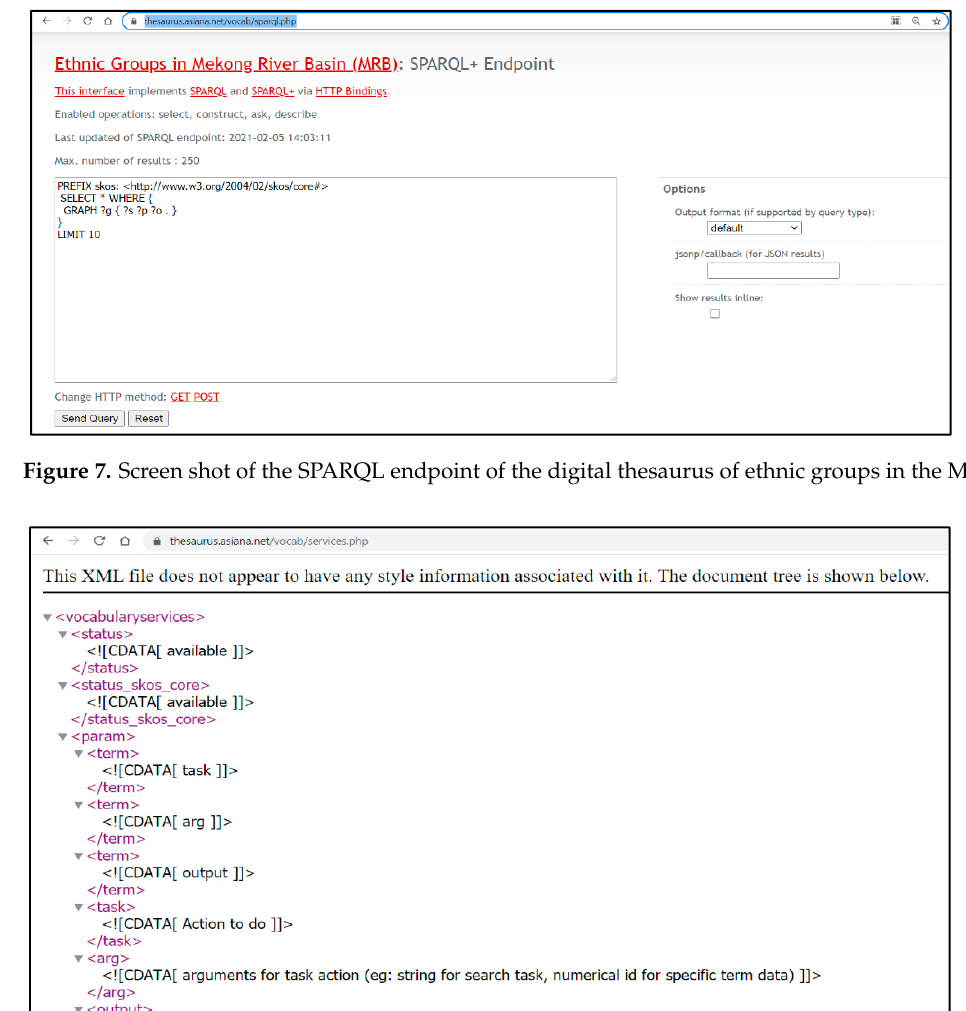
Figure 6. Search results for the term “Anu” with scope note, BT, and RT.